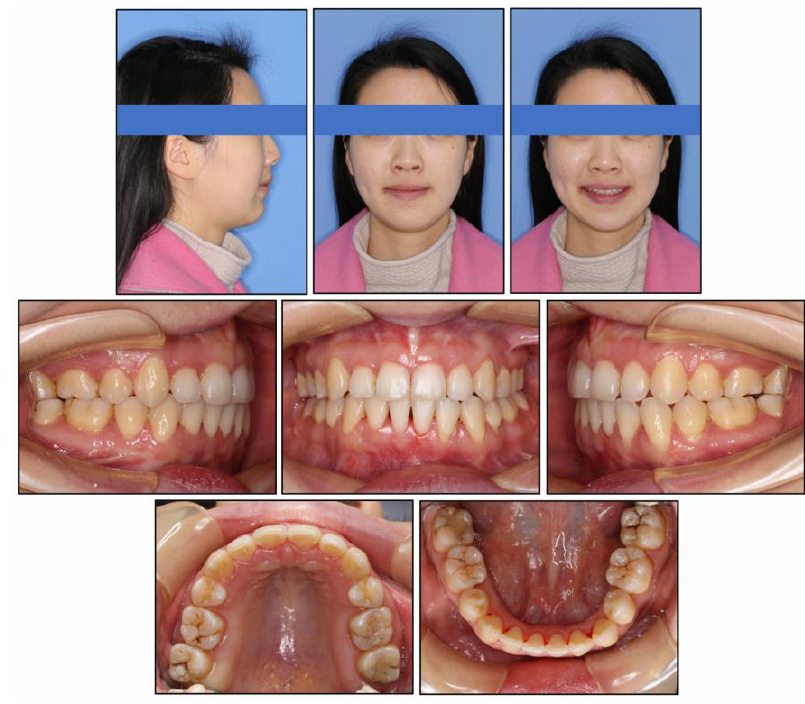
Figure 7. Post-treatment intraoral and facial photographs.